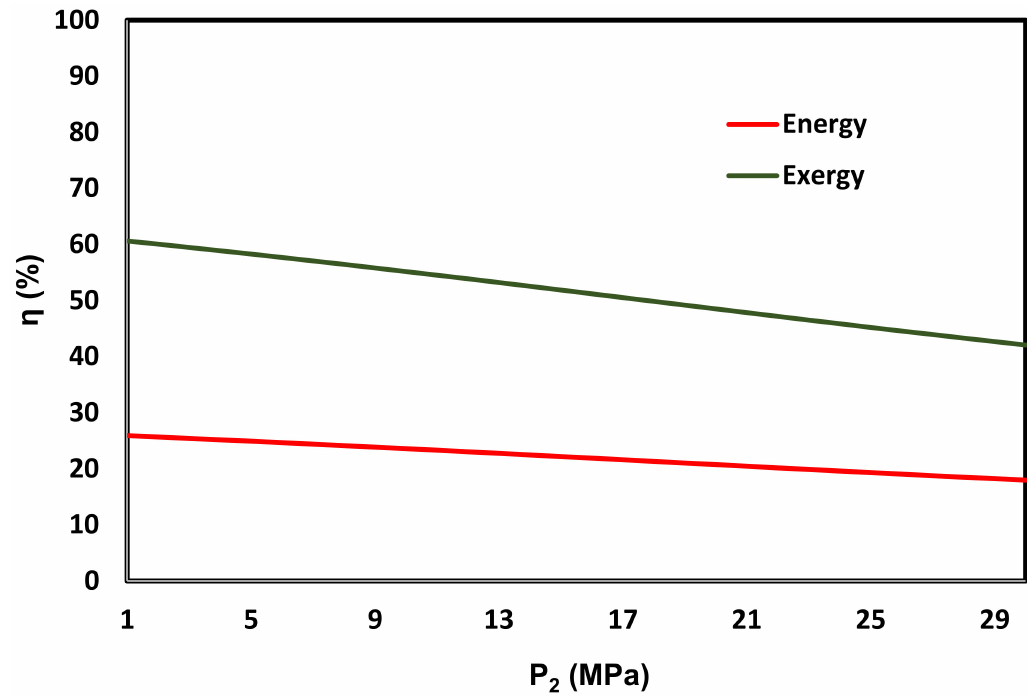
Figure 8. The variation in CO 2 cycle energy and exergy efficiencies with outlet pump pressure in the CO 2 cycle.